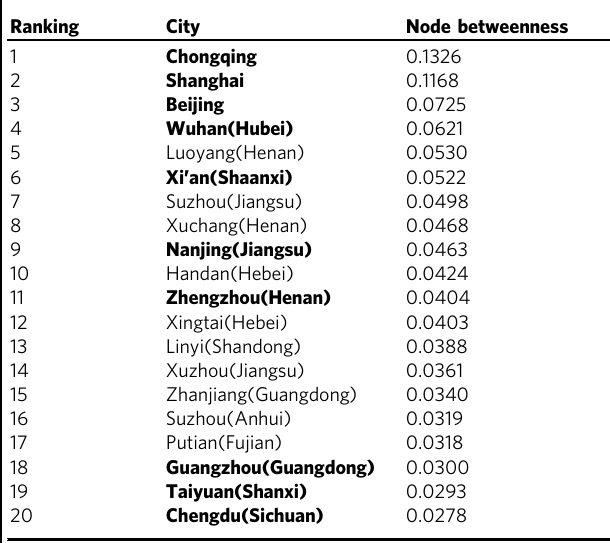
Table 1 Key cities with the highest node betweenness in city-level informal adoption network.